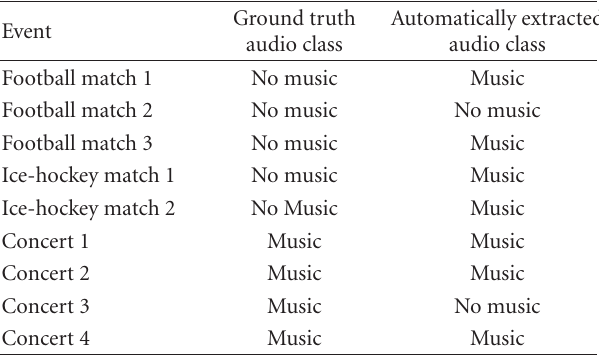
Table 1: Event genre classification results by analyzing only audio